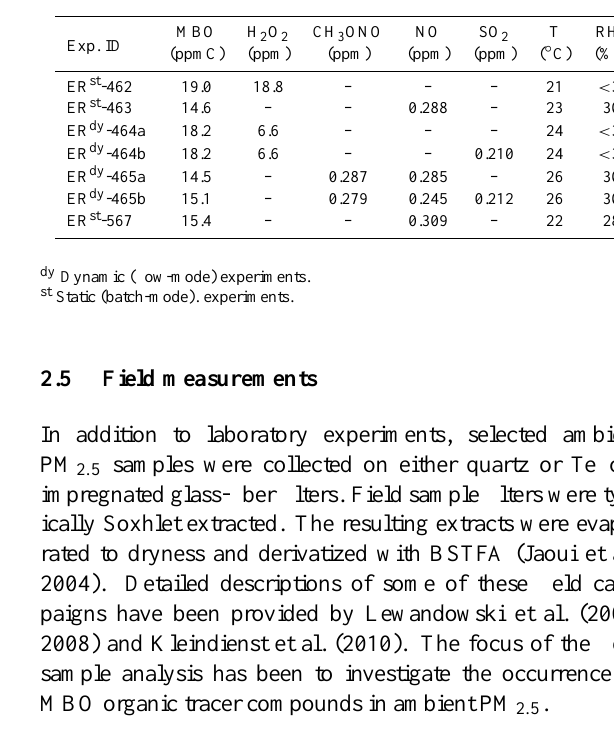
Table 1. Initial conditions for MBO experiments in the presence and absence of